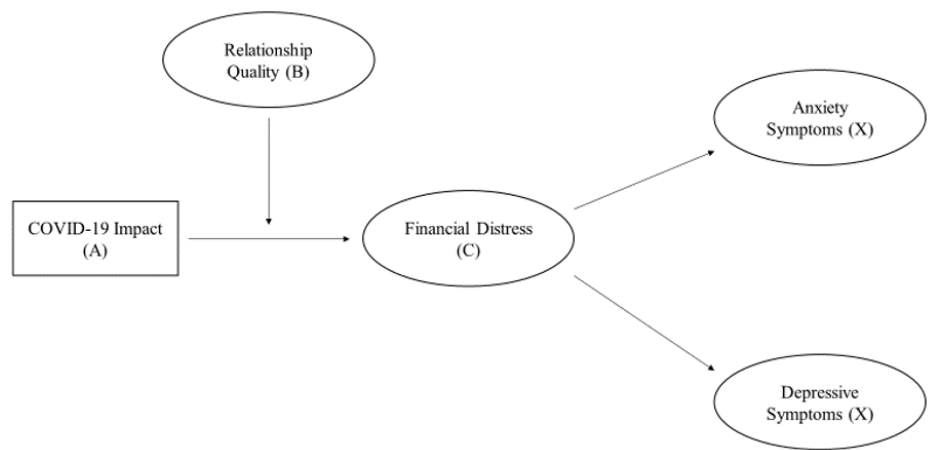
Figure 1. Conceptual Model of First-Stage Moderated Mediation. Note: Ellipses represent latent variables, and the rectangle represents an observed variable. For simplicity, we do not depict controlling for sex, age, and parents’ education level.